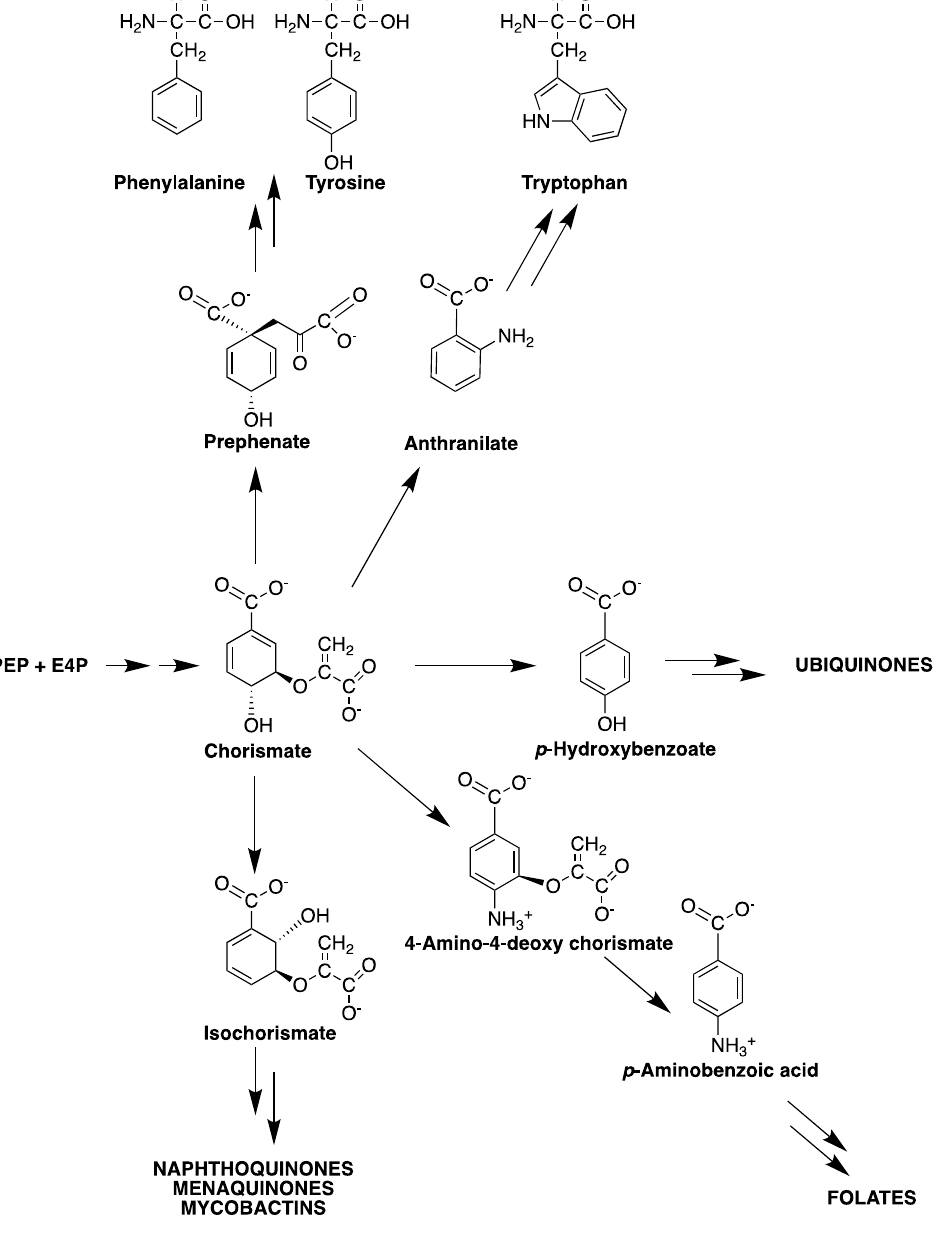
Figure 2. Chorismate: a metabolic node.